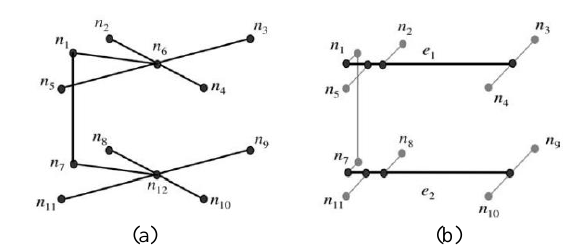
Figure 3. The modelling of indoor building path network (a) topologic model (b) geometric network model (Lee, 2001).